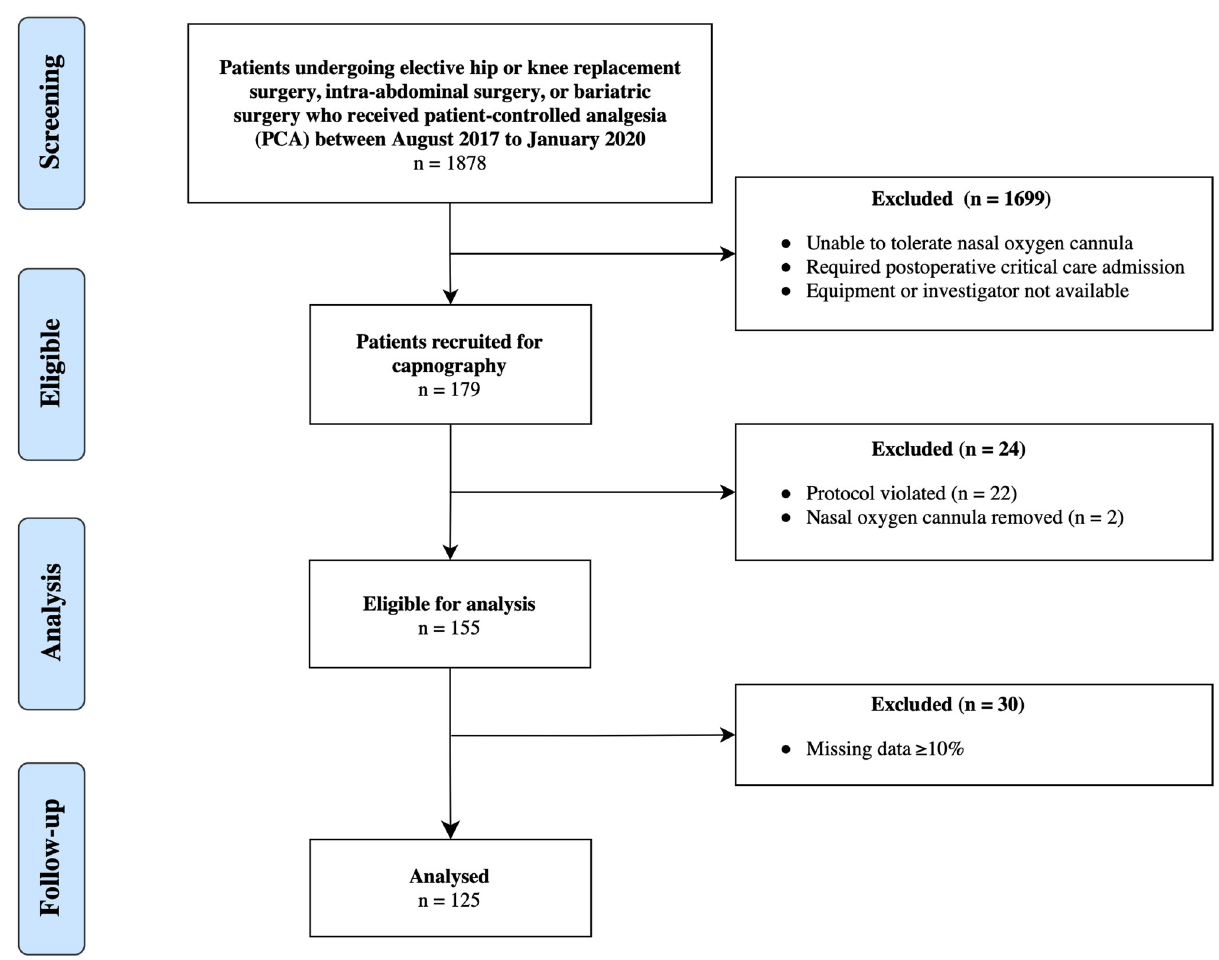
Fig 1. Patient flow diagram. Flow of patients through research study from screening to analysis.